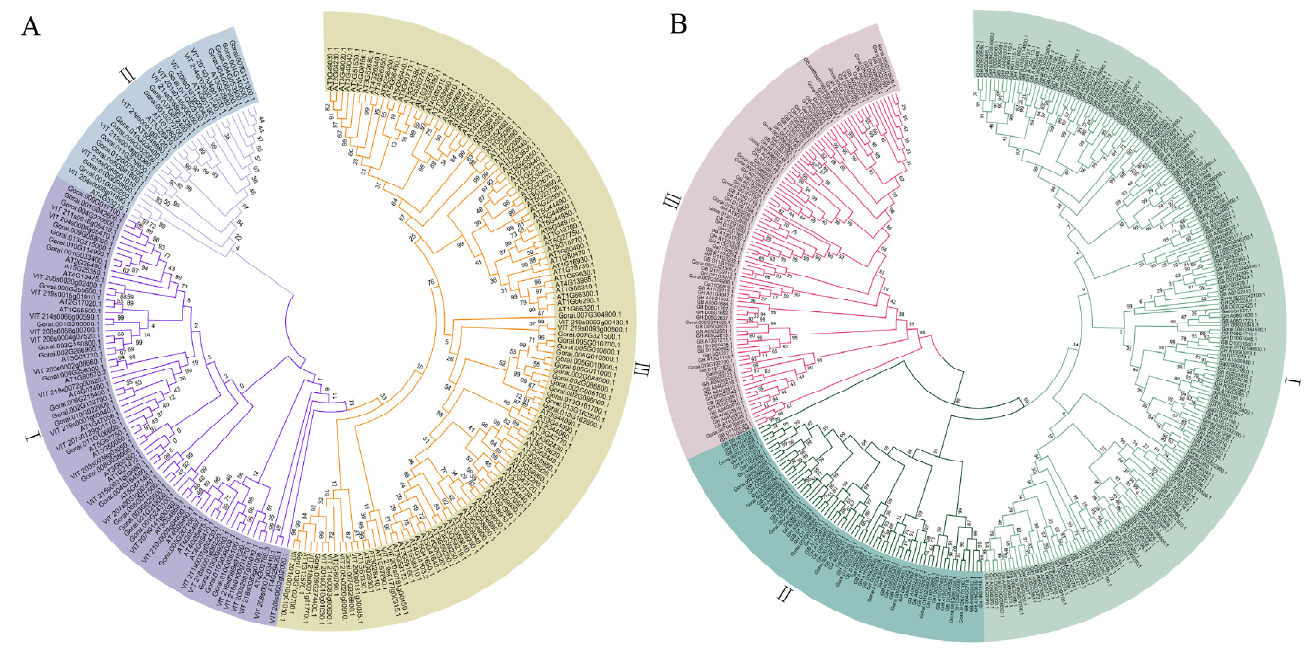
Figure 3. Phylogenetic relationship among FBXL proteins. ( A ) 227 FBXL genes from 3 plant species analyzed regarding the phylogenetic relationship. ( B ) 348 FBXL genes from 4 cotton species analyzed regarding the phylogenetic relationship. The two maximum likelihood (ML) phylogeny trees were constructed by the MEGA 7.0 software. The bootstrap method was used and replicated 1000 times. (I: Grpup I; II:Group II; III: Group III).